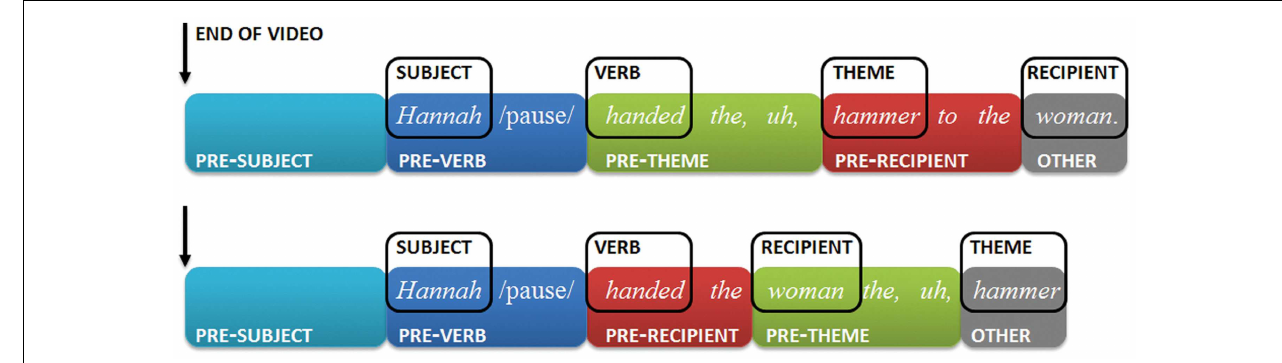
FIGURE 3 | Example sentence in theme-first (top) and theme-last order (bottom). The four annotation regions (pre-subject, pre-verb, pre-theme, and pre-recipient) are illustrated by colored